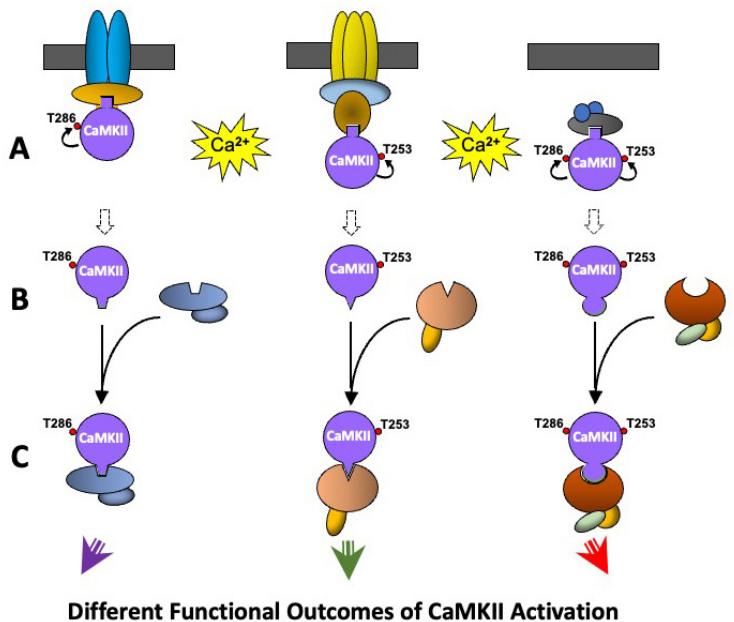
Figure 3. A schematic representation of how CaMKII in different molecular environments can respond to stimuli differently. The binding partner with which CaMKII is associated can influence the functional outcomes that occur following a rise in intracellular calcium. Coloured oblong shapes represent generic proteins with which CaMKII (purple disc) binds directly or indirectly. Dark Grey bar represents a membrane. Geometric protrusions from CaMKII, and indents in the binding proteins represent binding sites for CaMKII. The small red disc represents the phosphorylation of a protein. See text for explanation of the sequence of events shown in the Figure.